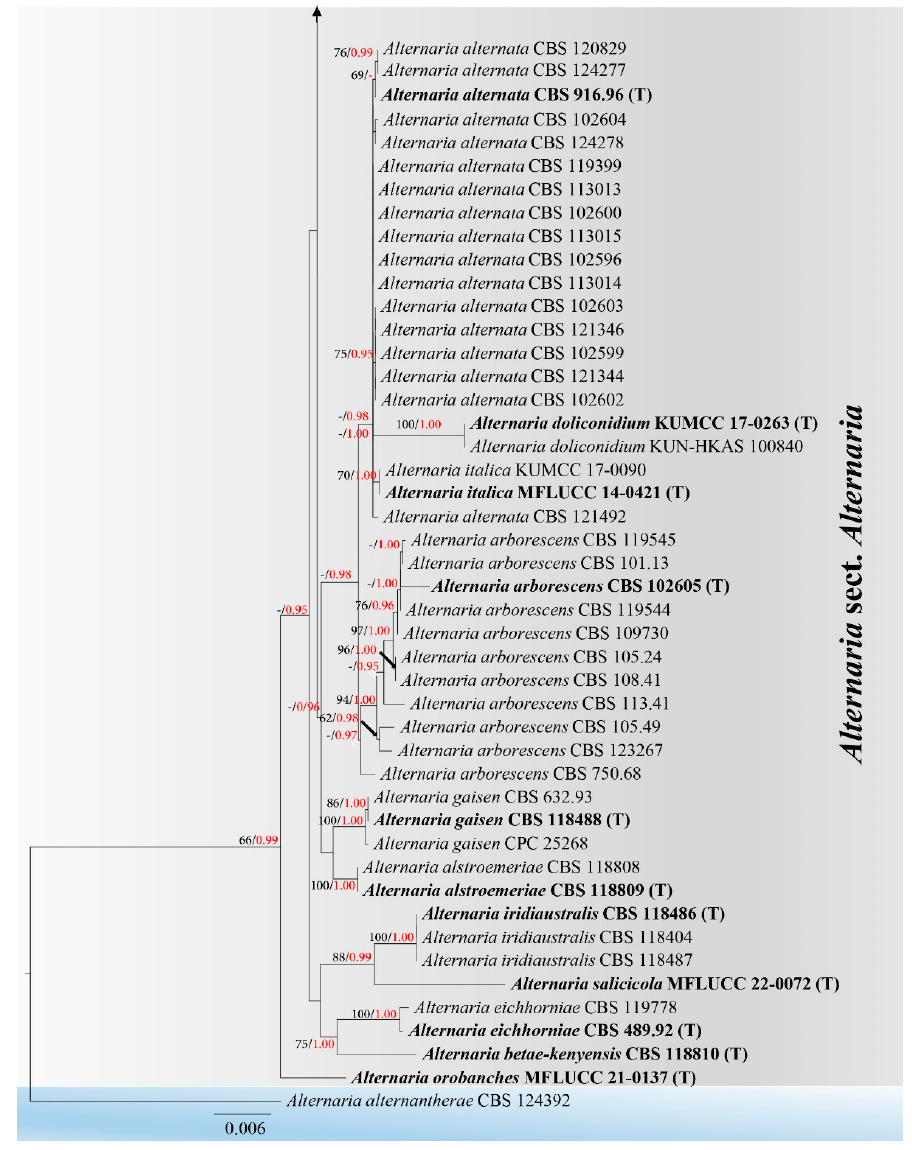
Figure 1. Phylogenetic tree of Alternaria sect. Alternaria generated by RAxML-based analysis of a combined ITS, LSU, SSU, tef1- α , rpb2 , gapdh and Alt-a1 DNA sequence dataset. Bootstrap support values for maximum likelihood (ML, black) equal to or greater than 60% and Bayesian posterior probabilities (PP, red) equal to or greater than 0.95 PP are shown above the nodes. The tree is rooted to Alternaria alternantherae (CBS 124392). Newly species and generated strains are in blue, and the type strains are indicated in bold. Strains obtained from ex-type living culture are indicated by (T) and strains obtained from holotype specimen are indicated by (H).